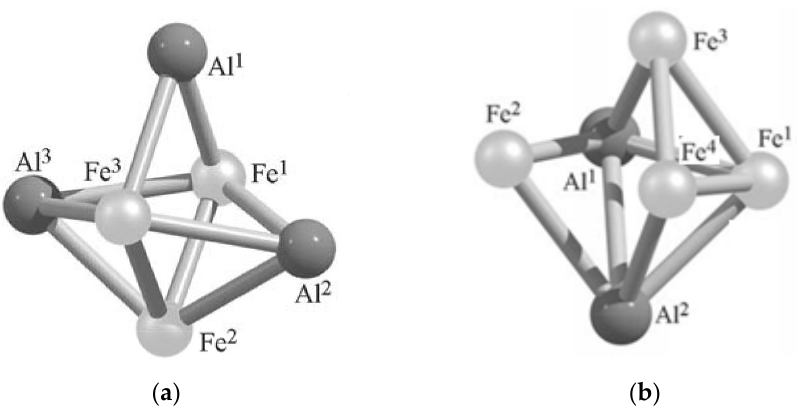
Figure 6. The images of molecular structures of most stable Al 3 Fe 3 ( a ) and Al 2 Fe 4 ( b ) isomers [95].